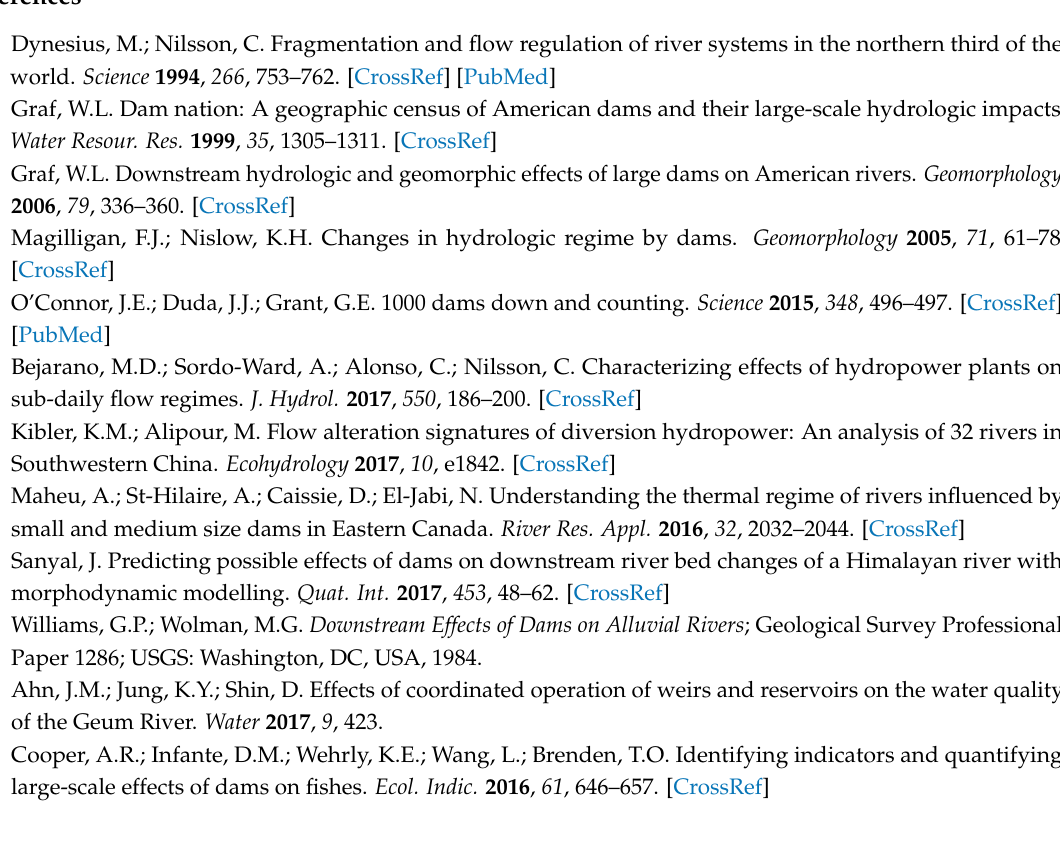
Figure S1: Monthly precipitation sum for 20 gauging stations in the Upper Narew catchment, Figure S2: Flow regime in Sura˙z gauging station 1951–2012. A—1st quartile monthly discharge, B—median monthly discharge, C—3rd quartile monthly discharge, Table S1: T test results of statistical significance of monthly precipitation sum between meteorological stations in the Upper Narew